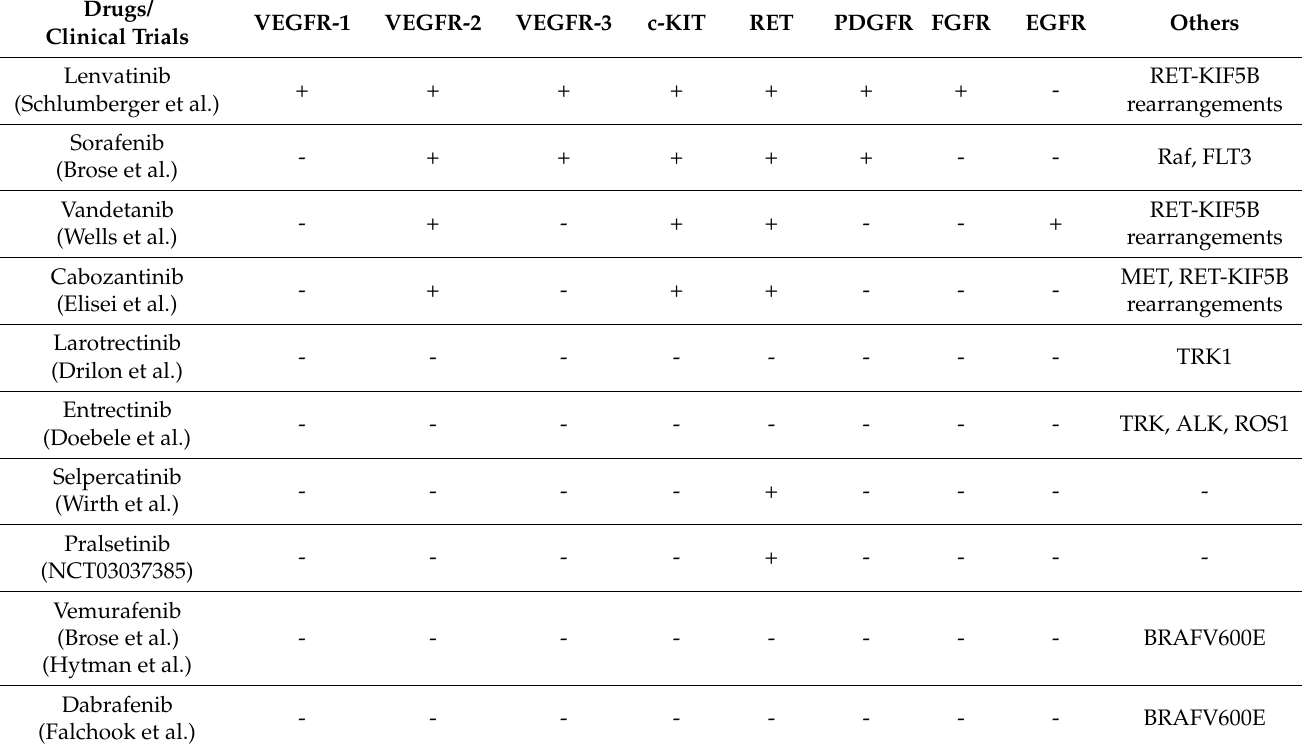
Table 1. Molecular targets of currently available tyrosine kinase inhibitors.